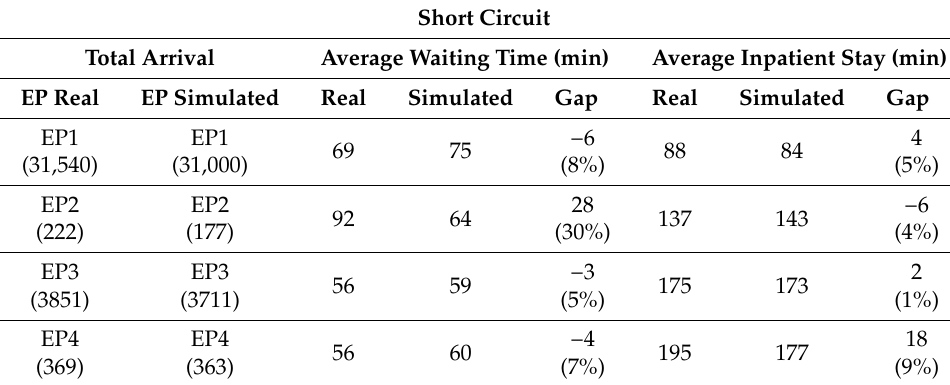
Figure 4. Comparison between real and simulated patient arrival. Table 2. Comparison of performance based on EP category—short circuit.